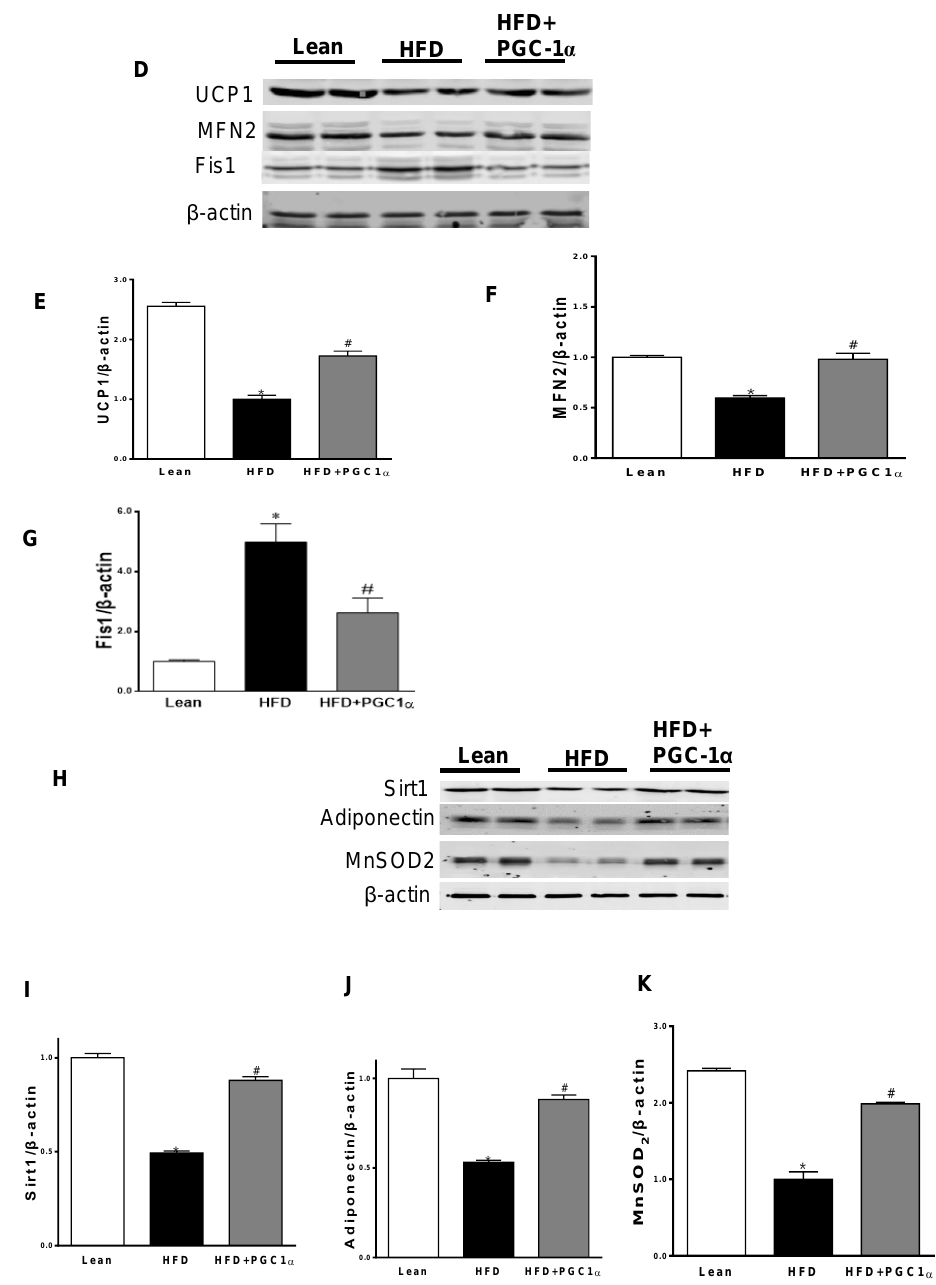
Figure 4. Effects of the Transgenic-adipo-PGC-1 α treatment on the key proteins involved in mito- chondrial fission and biogenesis and adipocyte browning. Representative Western blot analysis of ( A ) PGC-1 α and HO-1 ( B , C ), ( D – G ) MFN2, Fis1, and UCP1, ( H – K ) Sirt1, Adiponectin and MnSOD2 with their corresponding β -actin in the adipose tissue of lean, HFD and Transgenic-adipo-PGC-1